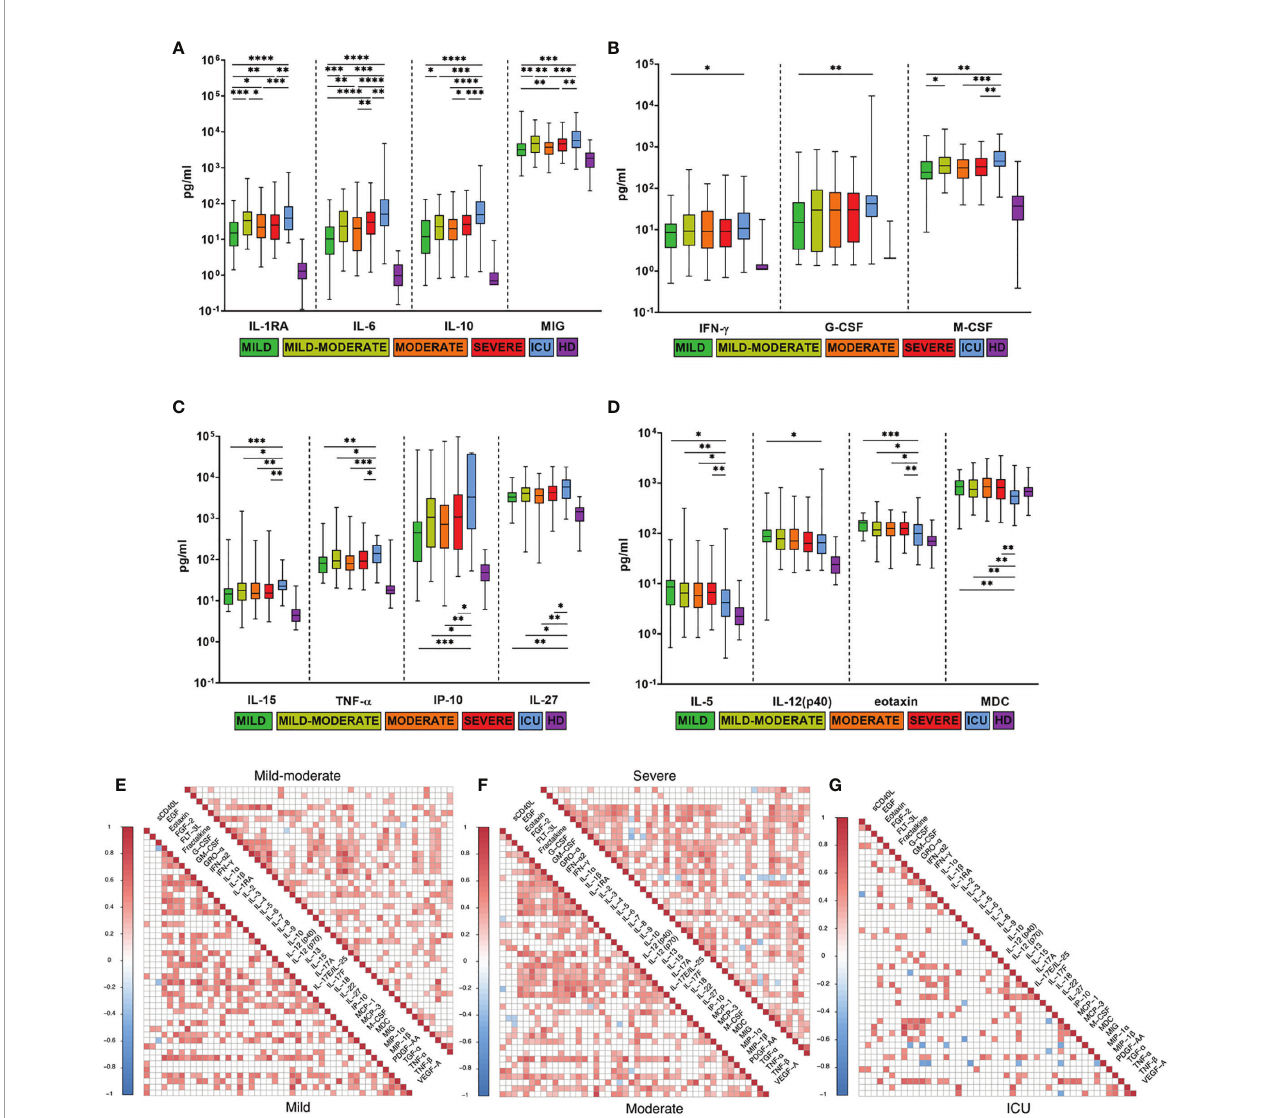
FIGURE 3 | Comparison of cytokine levels in COVID-19 patients with different disease severities. (A – D) Comparison of maximum cytokine levels from each patient (n=444) divided into fi ve severity groups: mild (n=41), mild-moderate (n=98), moderate (n=137), severe (n=129), ICU (n=39), HD (healthy donors, n=66). Boxes and whiskers represent medians with 95%CIs. Groups were compared by a two-tailed Mann – Whitney U-test for nonparametric comparison. *p< 0.05, **p< 0.01, ***p< 0.001, ****p< 0.0001. Compared with HD, all groups of COVID-19 patients had signi fi cantly higher levels of all examined cytokines ( p< 0.05), except MDC. (E – G) Cytokine correlation matrices for COVID-19 patients on the admission day (0-7 DfSO): mild (n=30), mild-moderate (n=54), moderate (n=59), severe (n=69) and ICU (n=22). Colors indicate Spearman correlation coef fi cients ( p< 0.05), and colorless squares indicate ns (not signi fi cant)